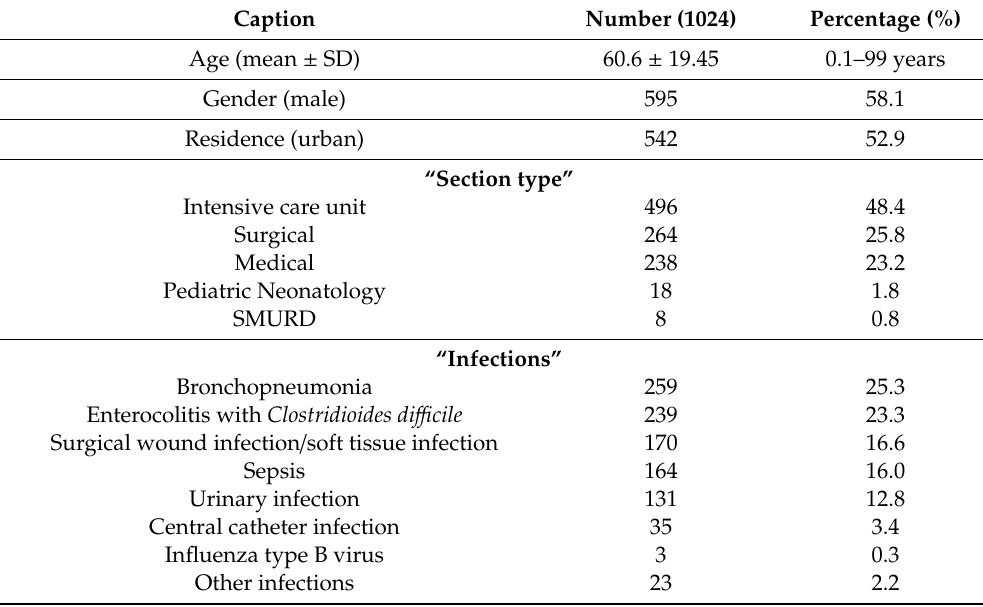
Table 1. Characteristics of the study